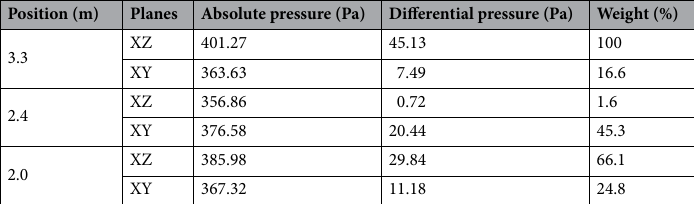
Table 2. Pressure values of XZ and XY planes at time t 1.